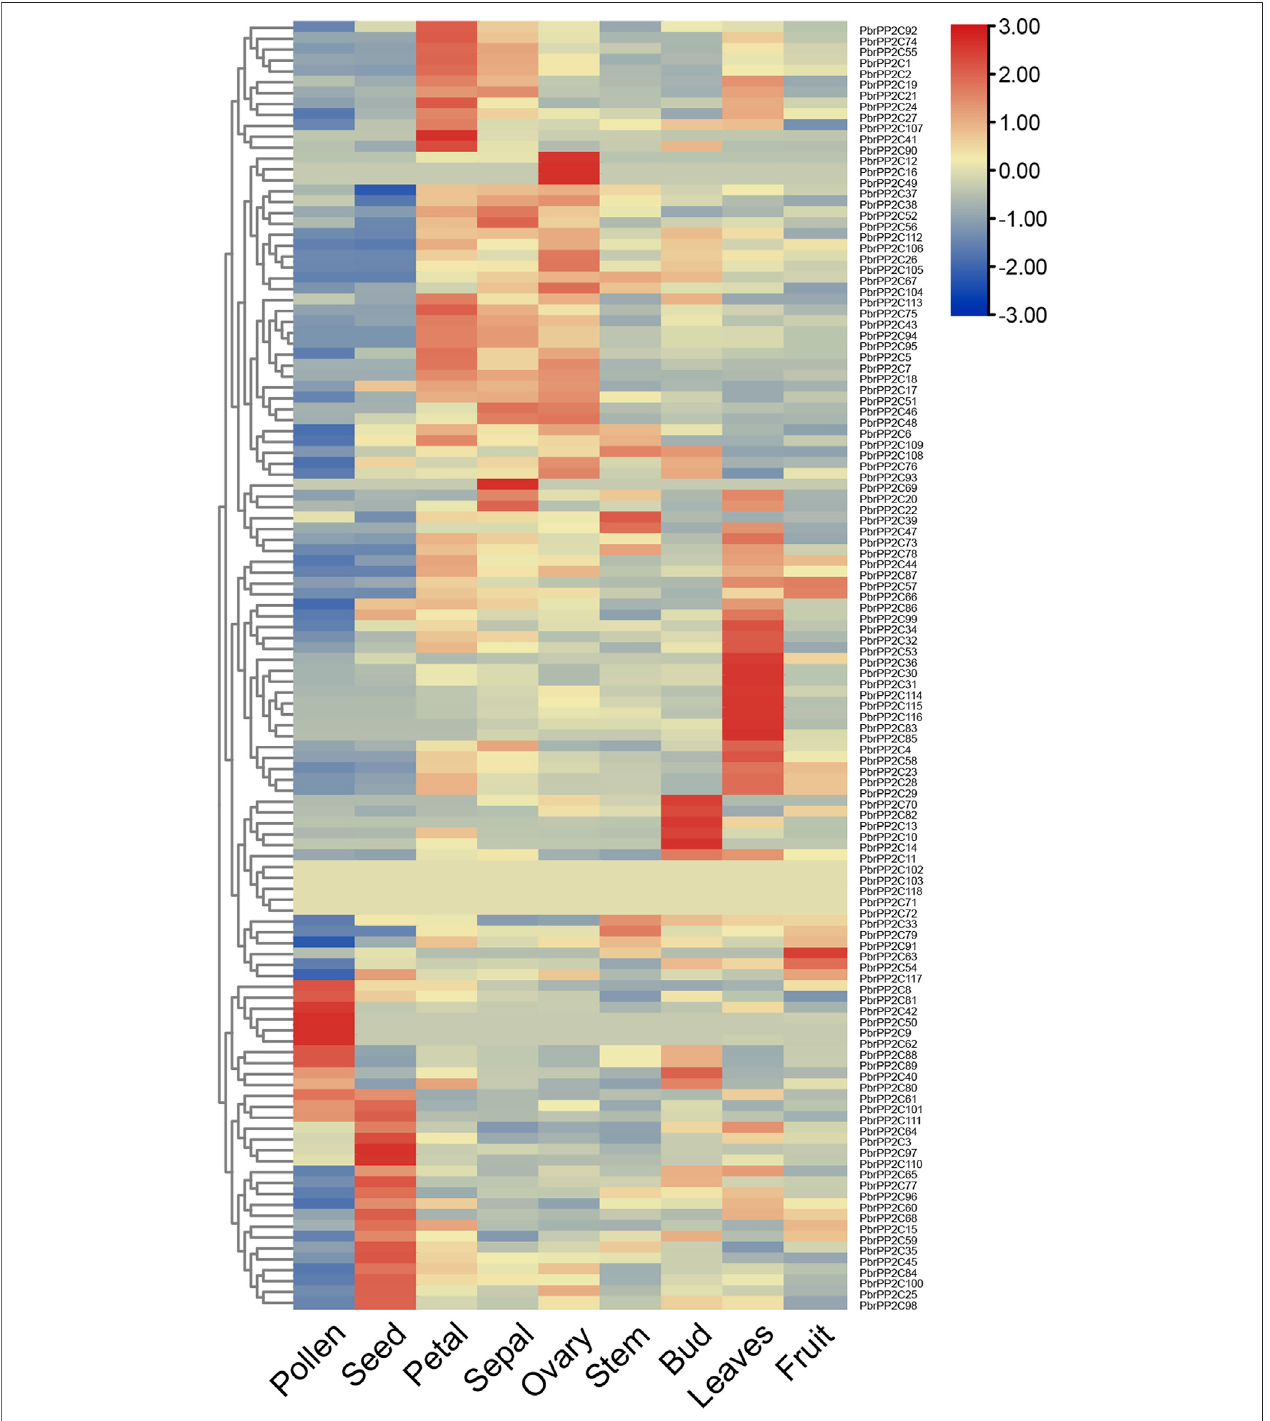
FIGURE 5 | Heatmap of expression pro fi les (FPKM) for PP2C in the nine various tissues of pear (pollen, seed, petal, sepal, ovary, stem, bud, leaf, and fruit). Expression levels are indicated by the color bar.